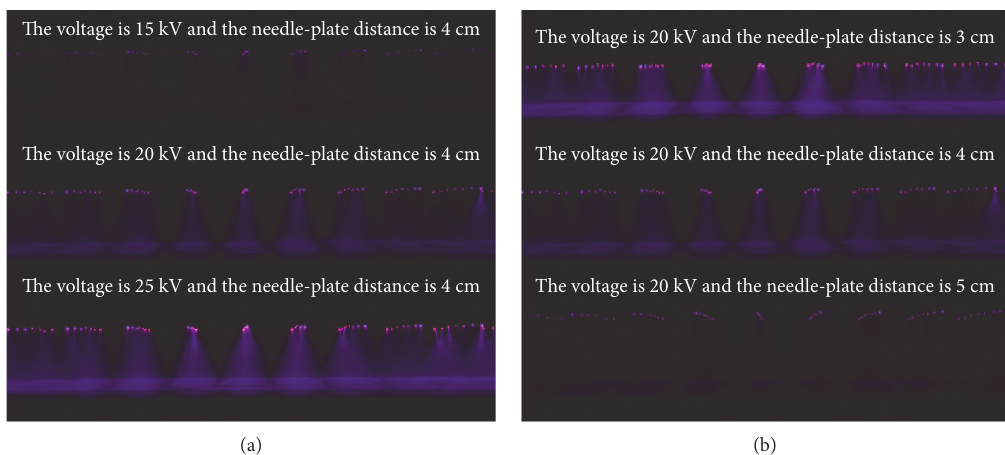
Figure 3: Plasma discharge diagrams at (a) needle-dielectric plate distance of 4cm and voltages of 15, 20, and 25kV and (b) voltage of 20kV and needle-dielectric plate distances of 3, 4, and 5 cm.